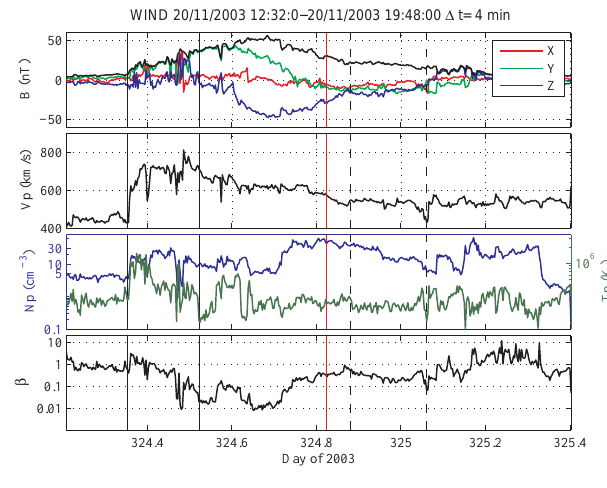
Fig. 9. Data from the WIND spacecraft. Same format as Fig.